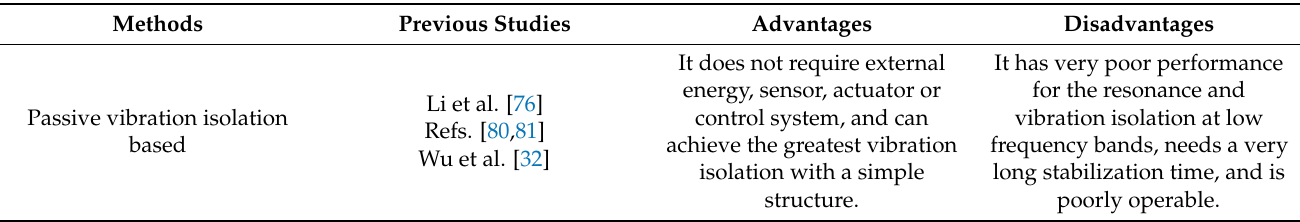
Table 2. Comparison of vibration isolation systems for an